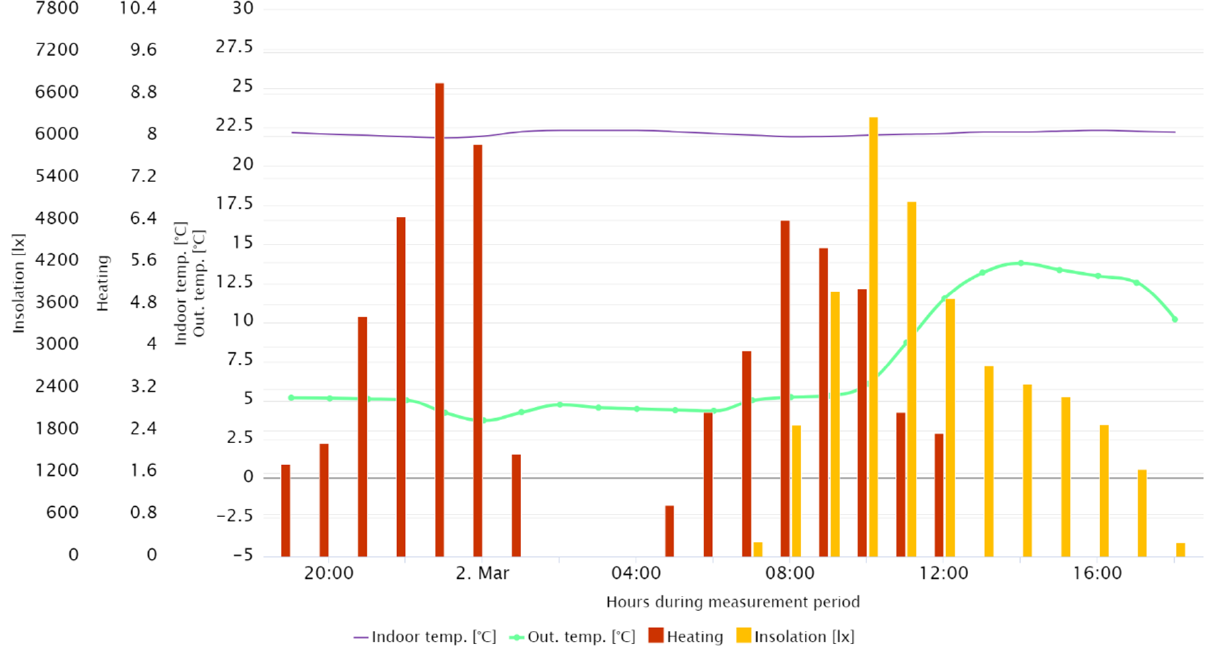
Figure 10. Twenty-four-hour period hourly averages of internal temperature for room 220 referring to heating valve position, insolation, and outdoor temperature.